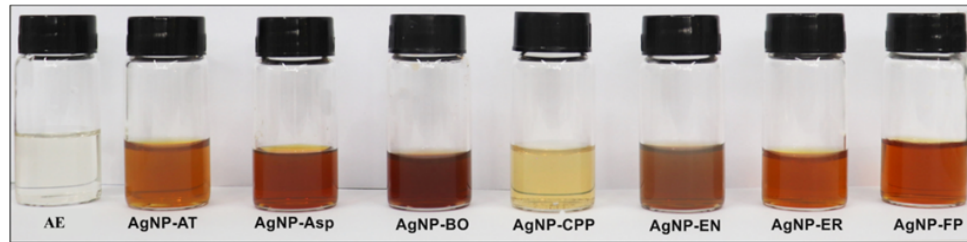
Figure 2. Color of the AgNP-AT, AgNP-Asp, AgNP-BO, AgNP-CPP, AgNP-EN, AgNP-ER, and AgNP-FP formed by the reaction of the extracellular cell free aqueous extract (AE) obtained using the fungi A. tubingensis , Aspergillus spp., B. ochroleuca , C. pini- ponderosae , E. nigrum , E. rostratum , and F. proliferatum with AgNO 3 . Pictures were obtained 96 h after the beginning of the reaction.